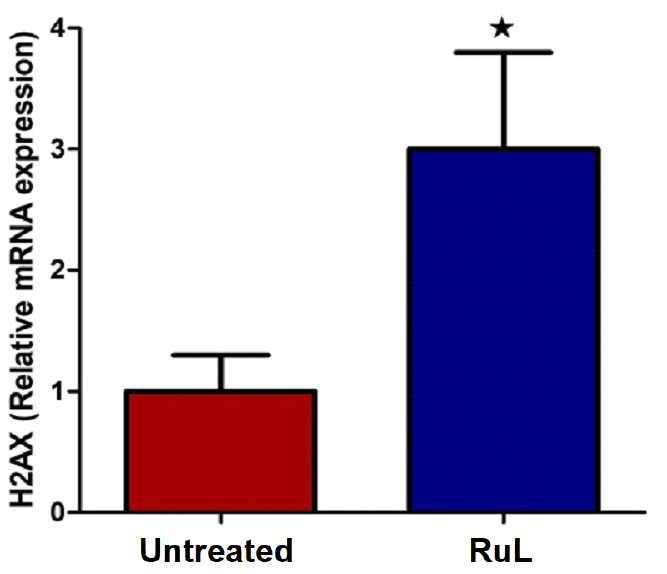
Figure 6. Effect of the RuL complex on the caspase 3 and 7 activities in HepG2 cells: ( A ) expression of caspase 3, ( B ) caspase 3 activity, ( C ) expression of caspase 7. Data are expressed as mean ± SD of two independent experiments performed in triplicate. Statistical differences were analyzed with a t -test. * Significant at p < 0.05.